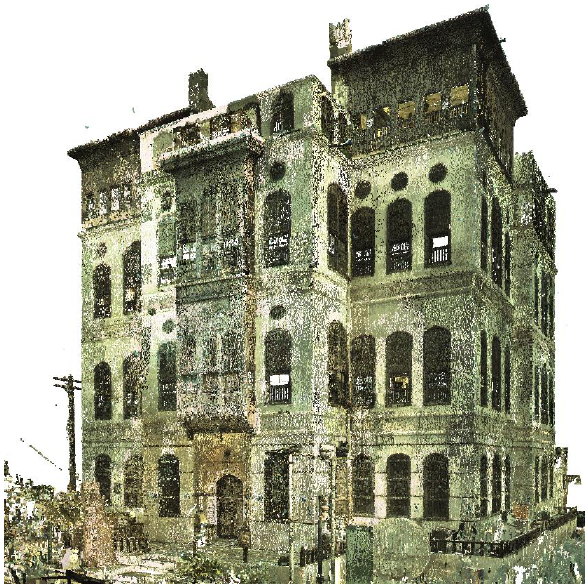
Figure 2: 3D LiDAR point cloud of Nasif Historical House.